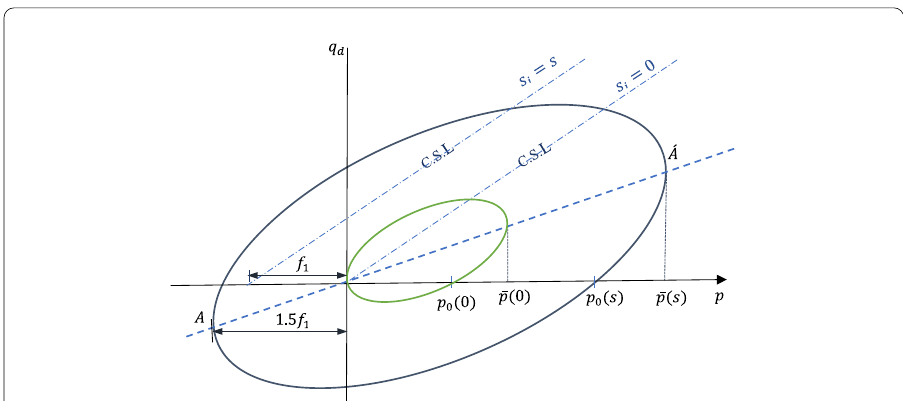
Fig. 14 Constant suction cross section of yield surface in